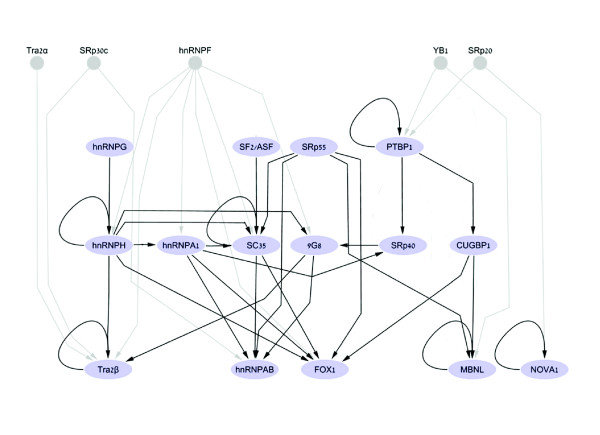
An induced subgraph of SF inter-regulation. The network represents AS regulation among SFs as predicted with the COS(WR) function. Arrows indicate that at least one of the alternative exons (and/or flanking introns) was predicted to be regulated by another factor. Light blue nodes stand for SFs that undergo AS and are thus part of the core network. SFs without AS support (the small gray nodes) are part of the extended network. The network is drawn in three layers: the upper layer displays SFs that have only out-edges (sources), the middle layer shows SFs that have both out-edges and in-edges (mixed), and the bottom layer includes SFs that have only in-edges (sinks). Graphs were drawn using Cytoscape [80].